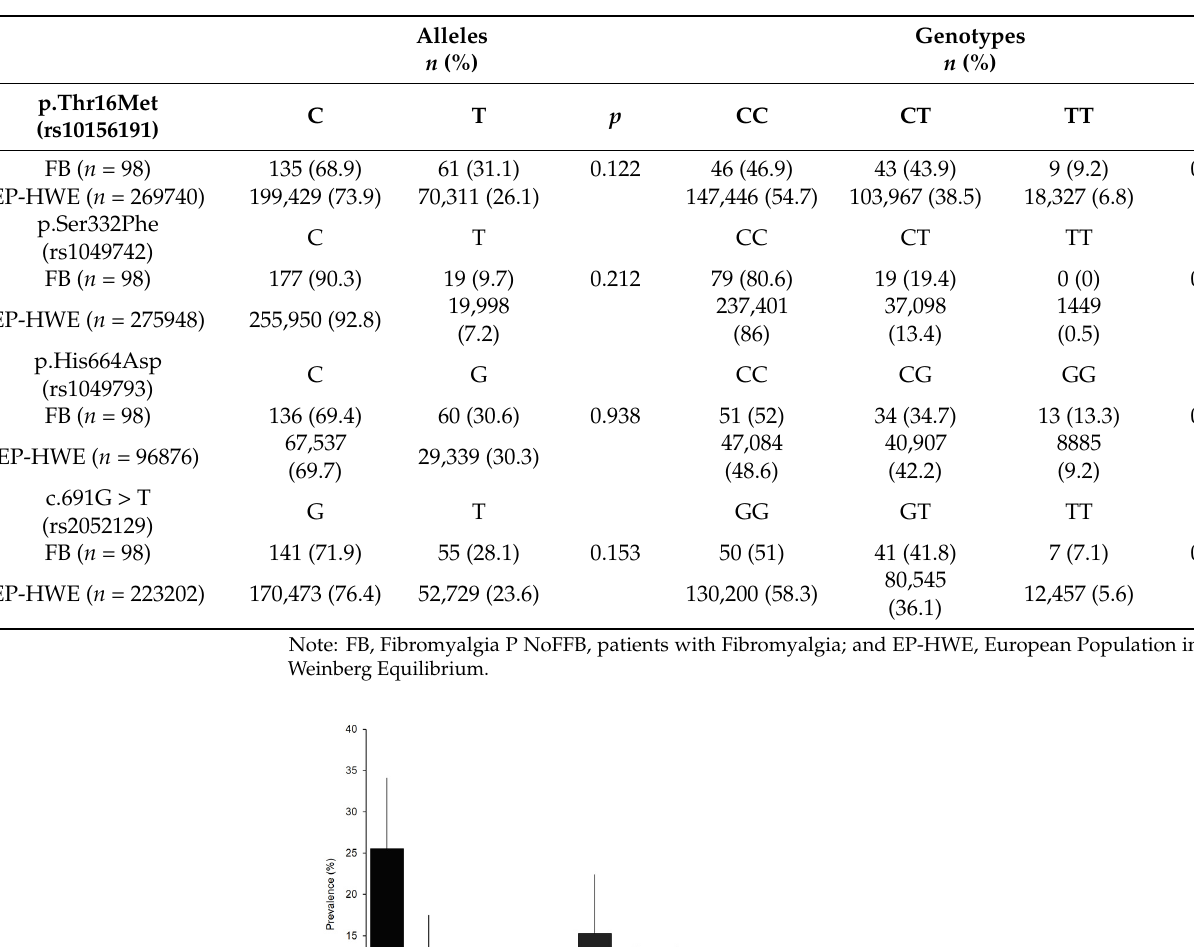
Table 1. Allelic and genotypic frequencies by variant for patients with fibromyalgia and the European population in Hardy–Weinberg equilibrium.